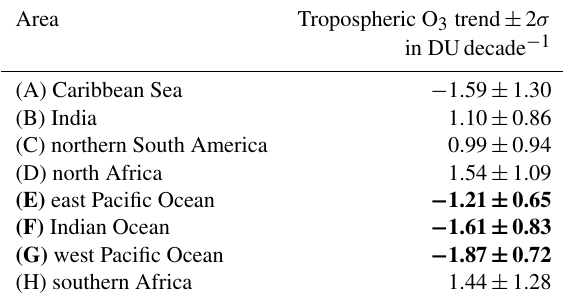
Table 2. Regional tropospheric ozone trends in eight tropical re- gions. In bold are the regions where the trend is greater than 3 times the standard deviation of the trend (3 σ